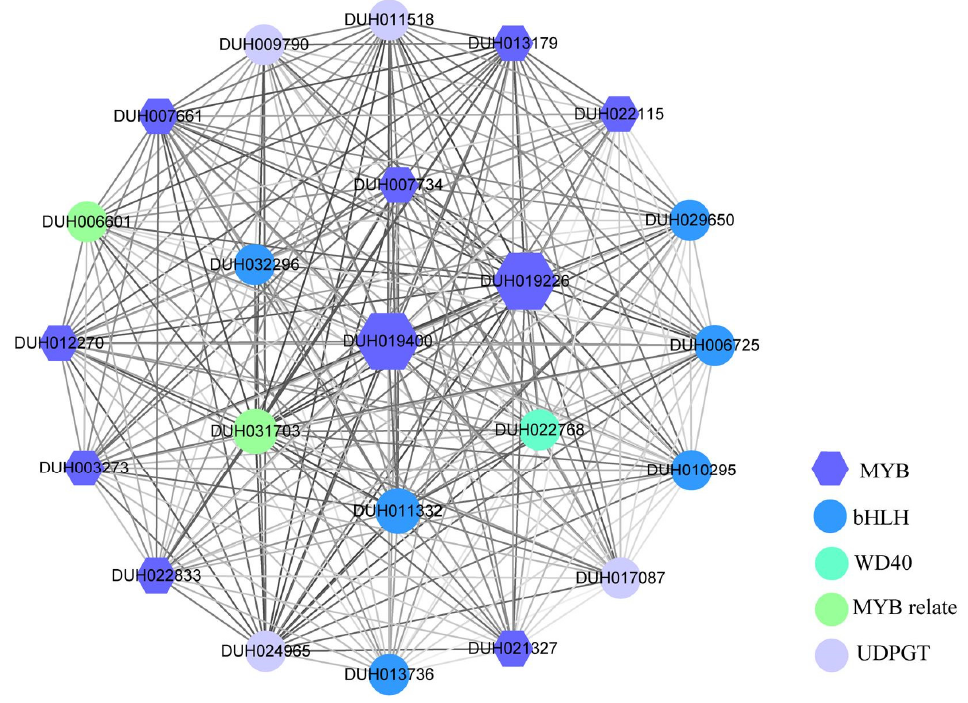
Figure 10. Visualization of hub genes in the MEturquoise module related to the a* value. Different color lumps represent distinct families, with a larger shape for a greater degree and a darker line for a greater weight.